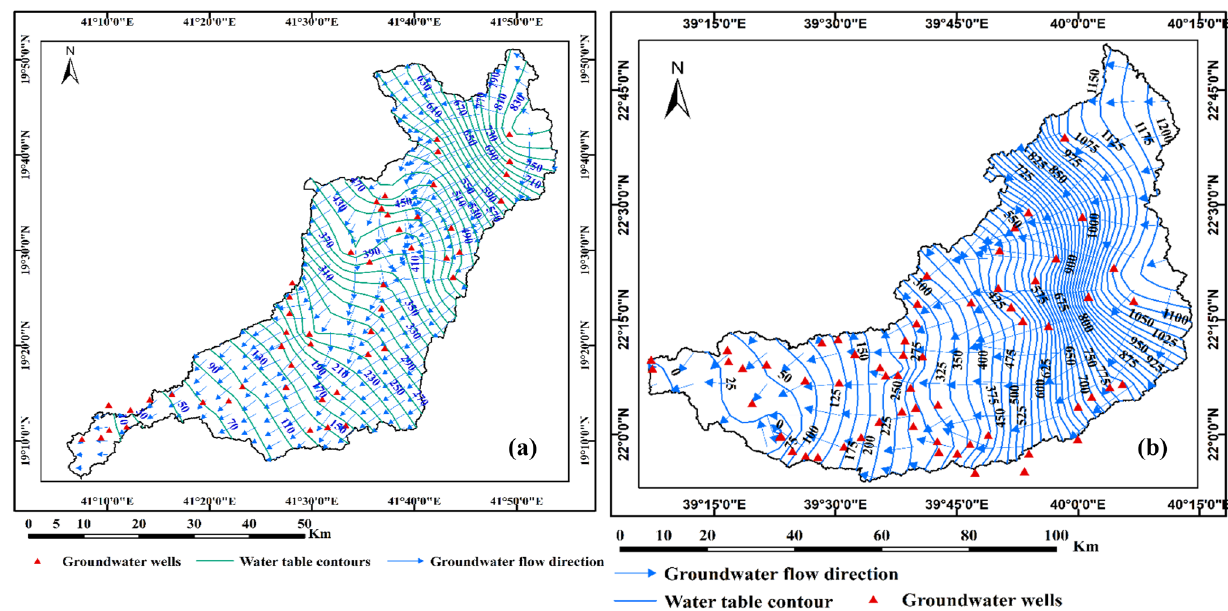
Table 3 Statistical analysis of the different physicochemical parameters of groundwater samples in Makkah Al-Mukarramah Province, KSA